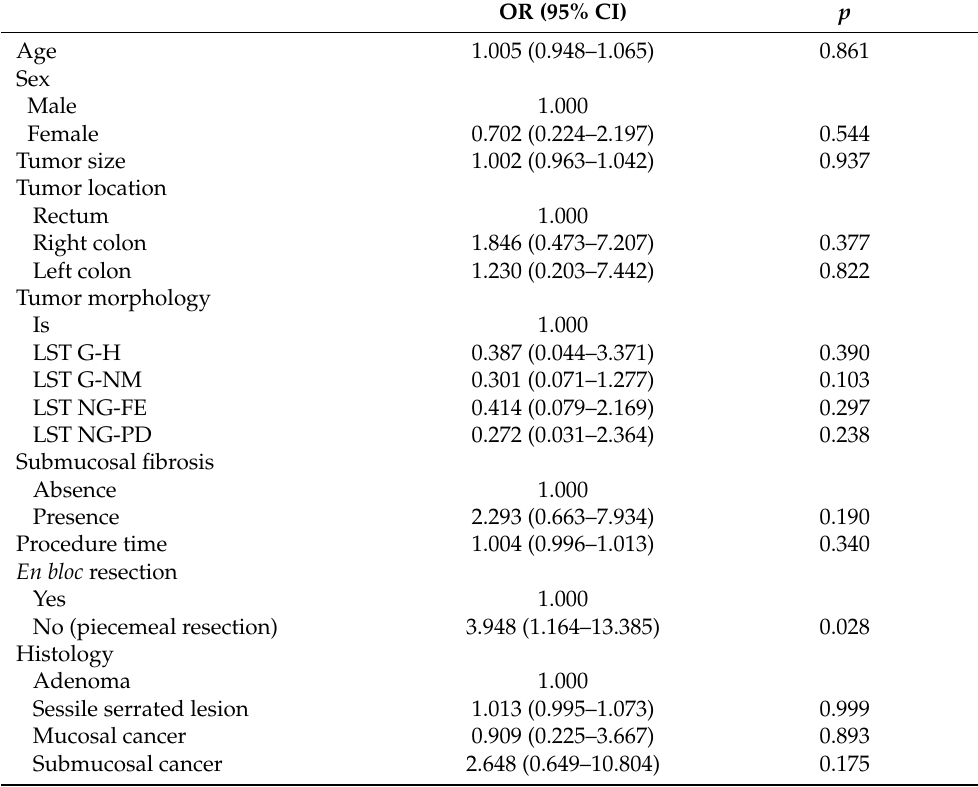
Table 3. Risk factors of local recurrence after colorectal